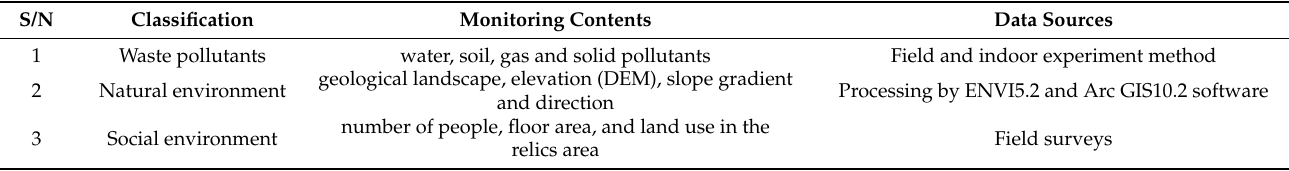
Table 1. Data sources and processing statistics.